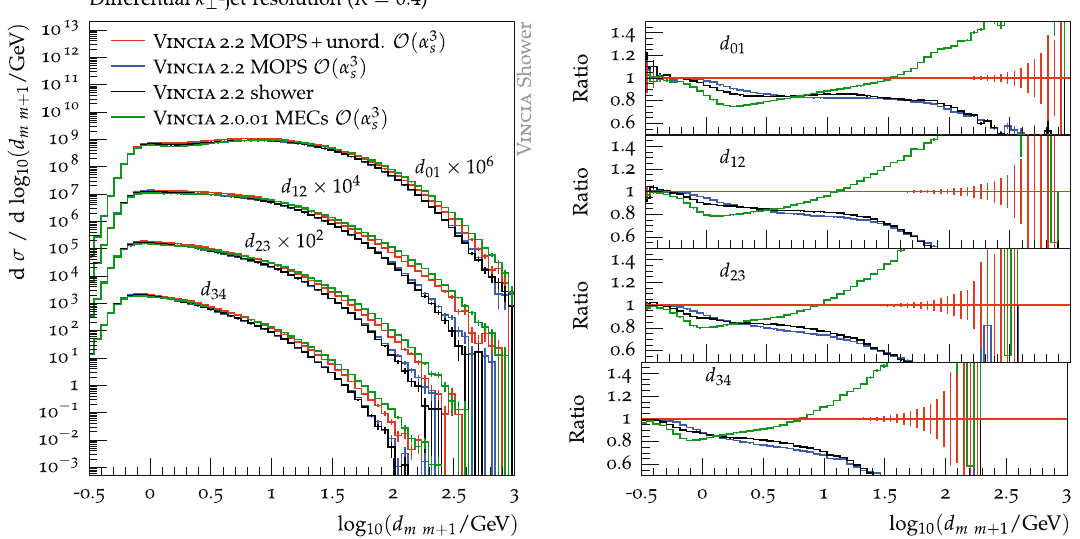
Fig. 3 Pythia 8.2.26+ Vincia 2.2 and Pythia 8.2.15+ Vincia 2.0.01 predictions for jet resolution measures in Drell–Yan events @ 7TeV. ME corrections are applied for ≤ 3